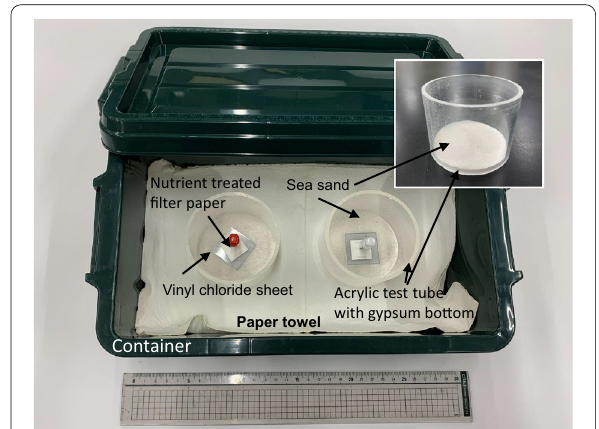
Fig. 2 Test chamber for no-choice feeding test